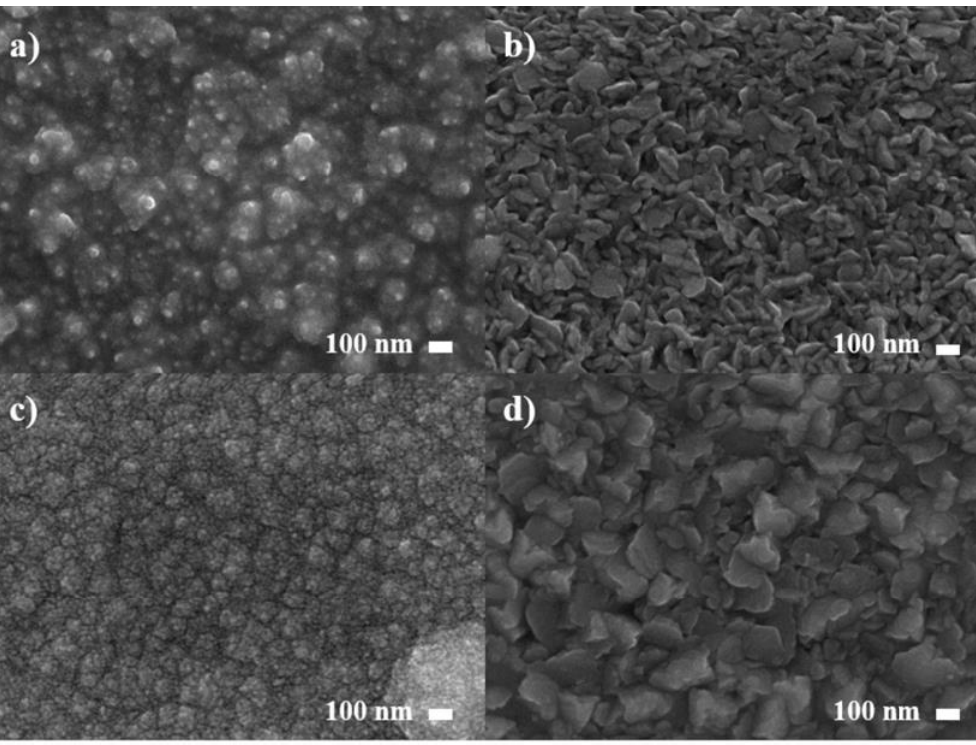
Figure 2. Thin films surface morphology ( a ) i-ZnO, ( b ) ZnO:Al, ( c ) ZnO:Ga, and ( d ) ZnO:In. The samples presented a thickness between 180 nm and 450 nm, as can be observed in Figure 3 where films’ cross-section micrographs are shown.